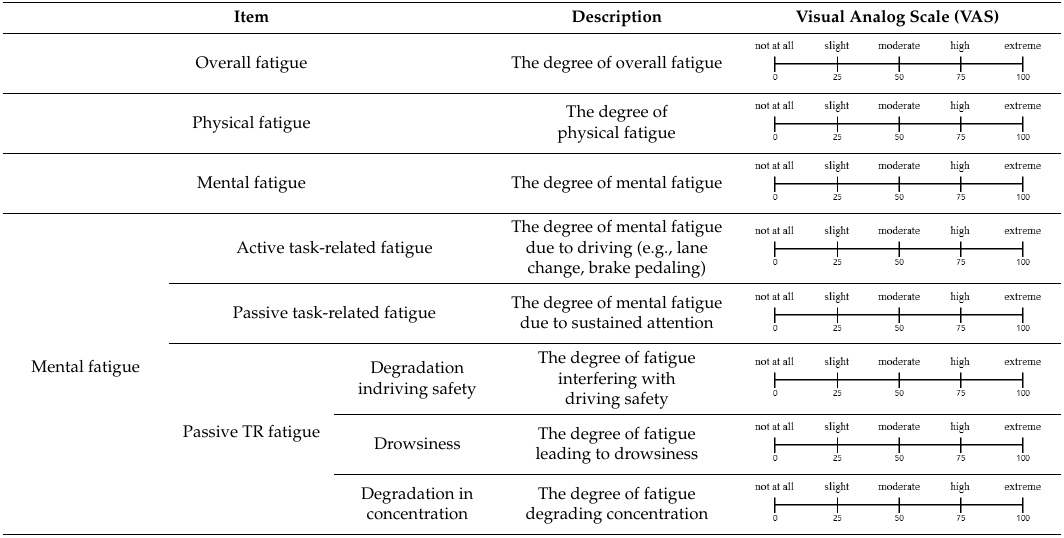
Table 2. Driver’s fatigue assessment questionnaire.